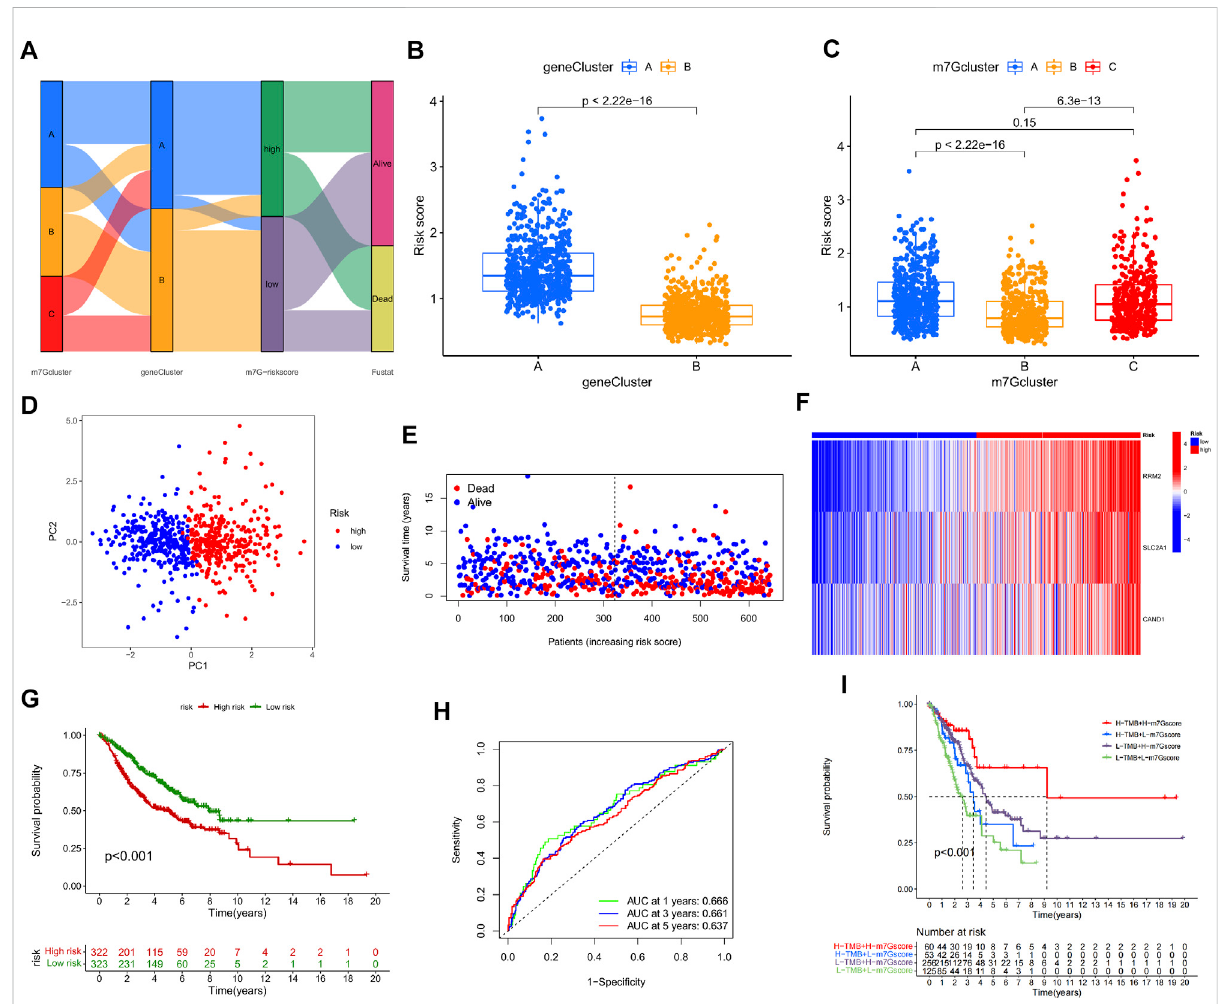
FIGURE 6 Construction and validation of m7G-Riskscore. (A) Sankey diagram of the clinical outcomes of patients in three m7G-Clusters, two gene clusters, and high- and low-risk groups. (B) m7G-Riskscore in two gene clusters. (C) m7G-Riskscore in 3 m7G-Clusters. (D) PCA. (E) Distribution of m7G-Riskscore. (F) Heatmap of the expression of the 3 signature genes (RRM2, SLC2A1, and CAND1). (G) Kaplan – Meier OS curves. (H) ROC curves for 1-, 3-, and 5-year OS. (I) Kaplan – Meier OS curves for LUAD patients strati fi ed using m7G-Riskscore plus